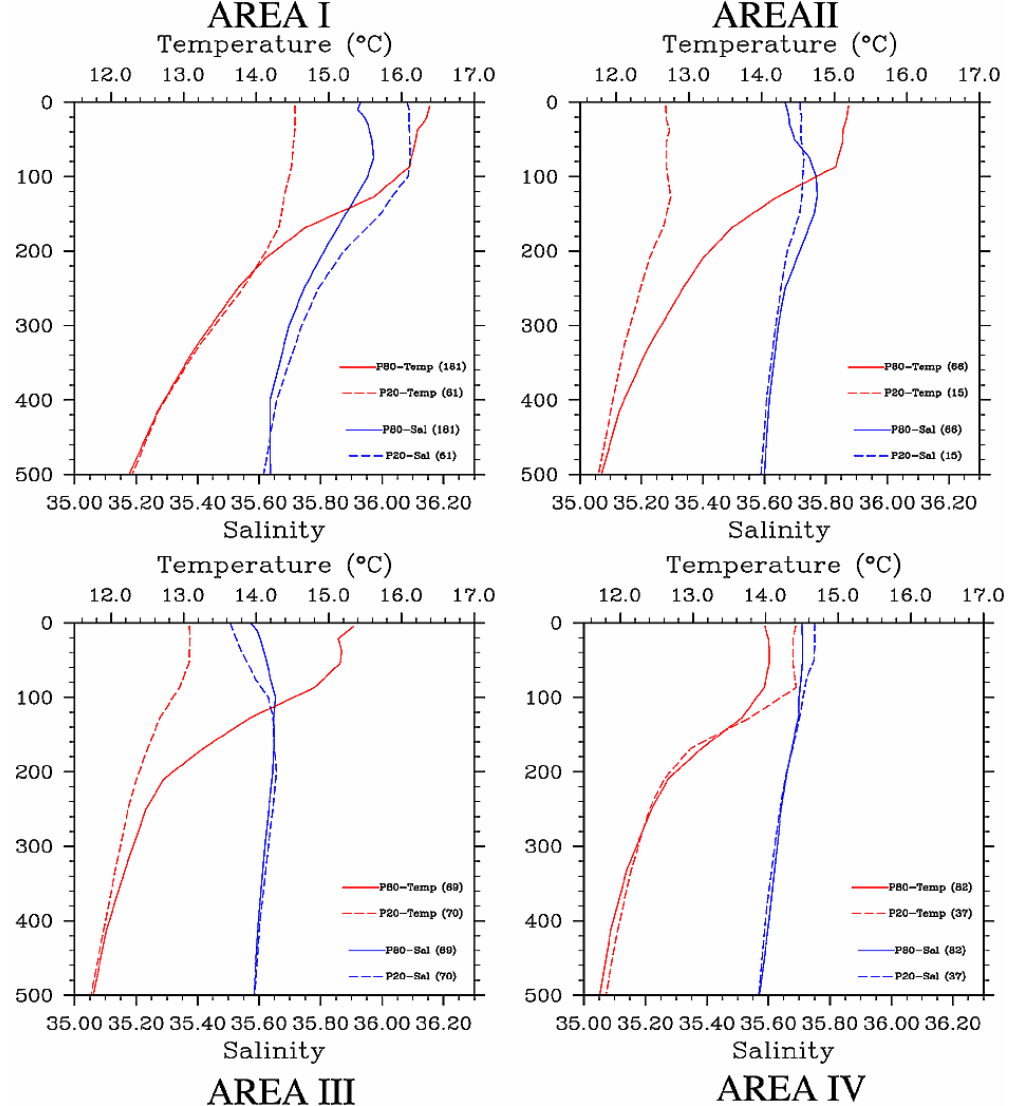
Fig. 8. Mean vertical temperature (red) and salinity (blue) composite profiles related to the P80 (solid lines) and P20 (dashed lines) day sets. Profiles for the ± 5days of each day in the P80 and P20 day sets are taken into account. The numbers of vertical profiles involved in each case is given in parenthesis by its corresponding label. Each of the 4 figures belongs to the corresponding area shown in Fig.